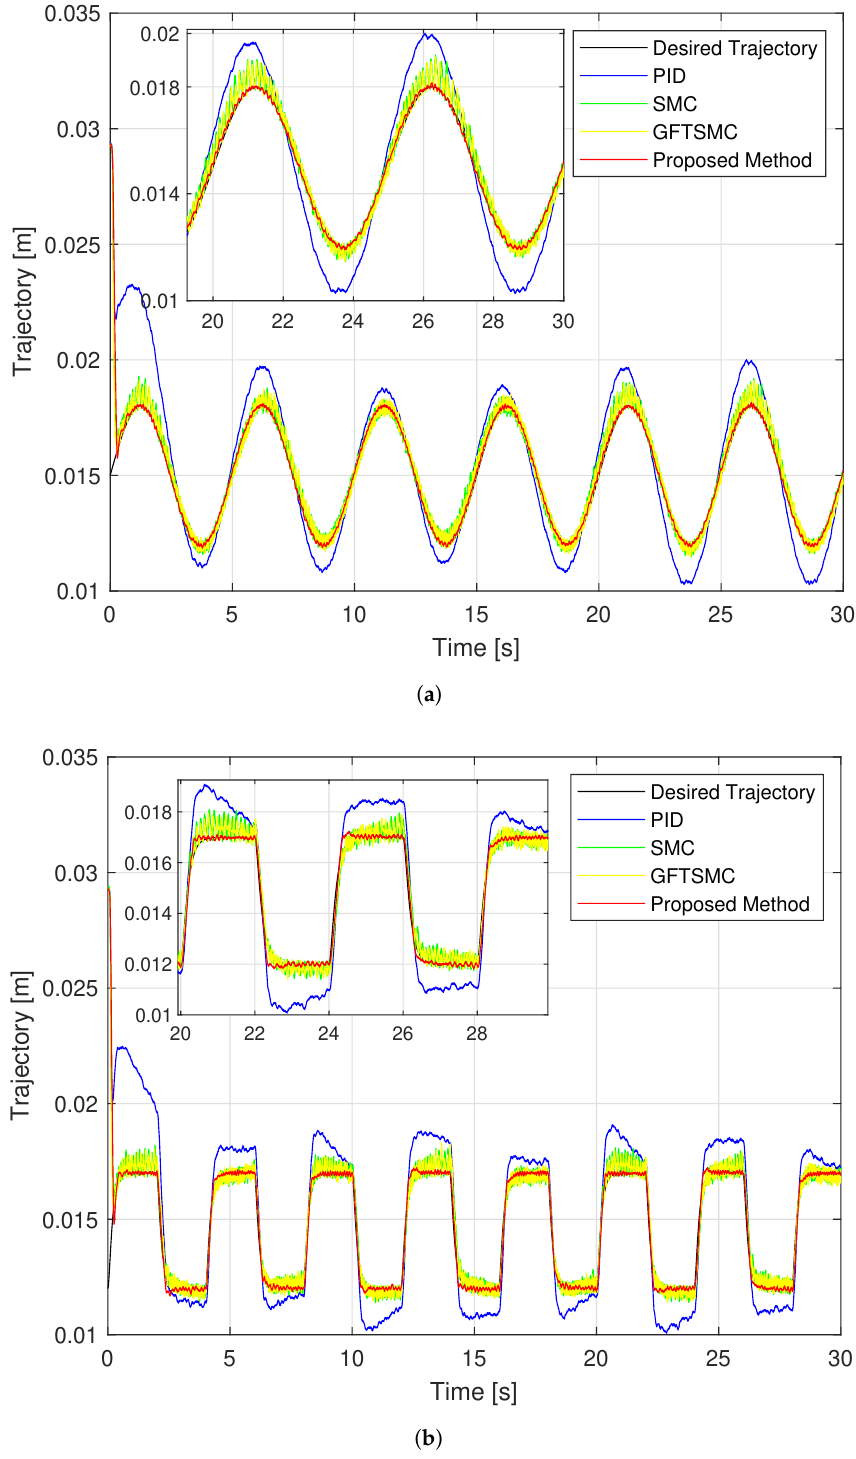
Figure 11. Comparison of the controlled ball trajectory with the desired trajectory using four separate controllers; ( a ) in case of sinusoidal orbit; ( b ) in case of a rest-to-rest